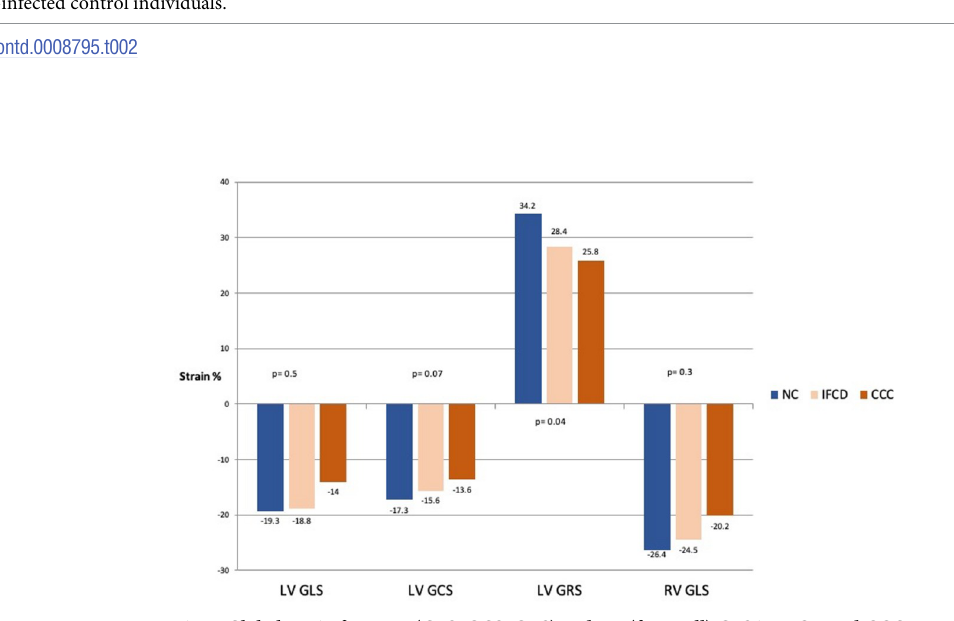
Fig 2. Global strain from LV (GLS, GCS, GRS) and RV (free wall) GLS in IFCD and CCC groups. Fig 2 shows median values of each studied group (NC, IFCD and CCC) of LV GLS, GCS, GRS and RV GLS. All indexes of LV and RV global deformation express a tendency of reduction from NC to IFCD and to CCC. IFCD = Indeterminate Form of Chagas disease; CCC = Chronic Chagas cardiomyopathy; LV = left ventricle; RV = right ventricle; GLS = global longitudinal strain; GCS = global circumferential strain; GRS = global radial strain. p-value of comparison between NC vs